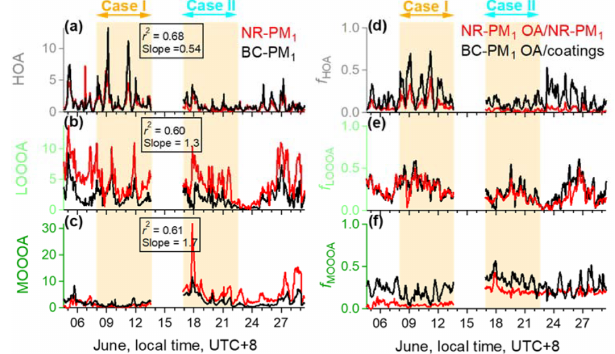
Figure 3. Temporal variations of NR − PM 1 and BC − PM 1 (a– c) HOA, LO-OOA, and MO-OOA and ( d and e ) their fractions. NR − PM 1 OA factors are in red, and the BC − PM 1 OA factors are in black. Here BC − PM 1 MO-OOA is the sum of A-BBOA, OOA2 (sulfate-related OOA), and OOA3 (nitrate-related